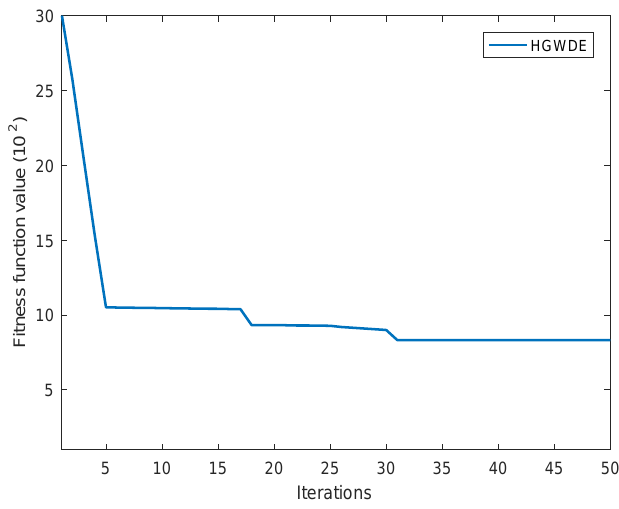
Figure 10. Evolution of the cost